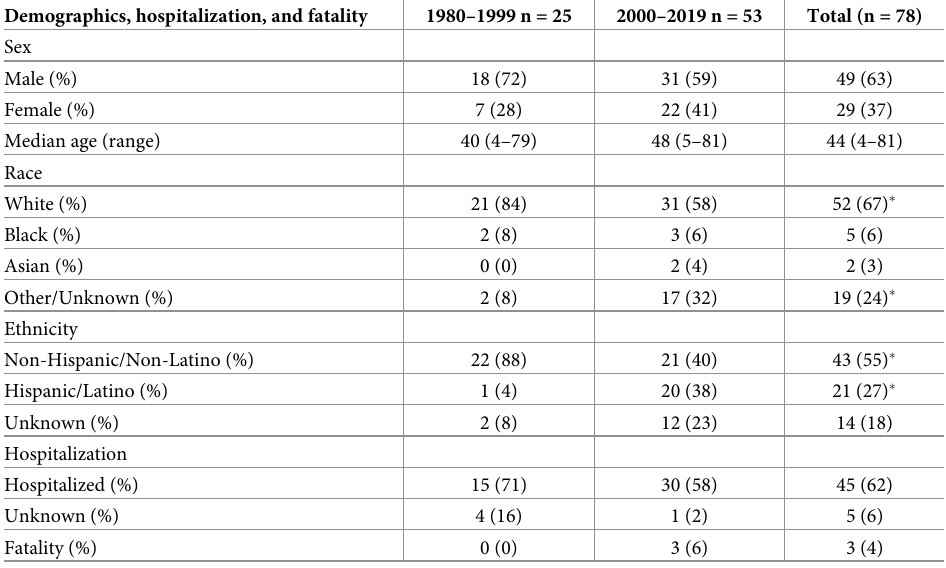
Table 1. Demographics, hospitalization, and fatality of reported RMSF cases in California in two 20-year report- ing blocks, 1980 to 1999 and 2000 to 2019. Asterisks indicate where there are statistically differences in proportions with a Z test, p < 0.05 considered significant.